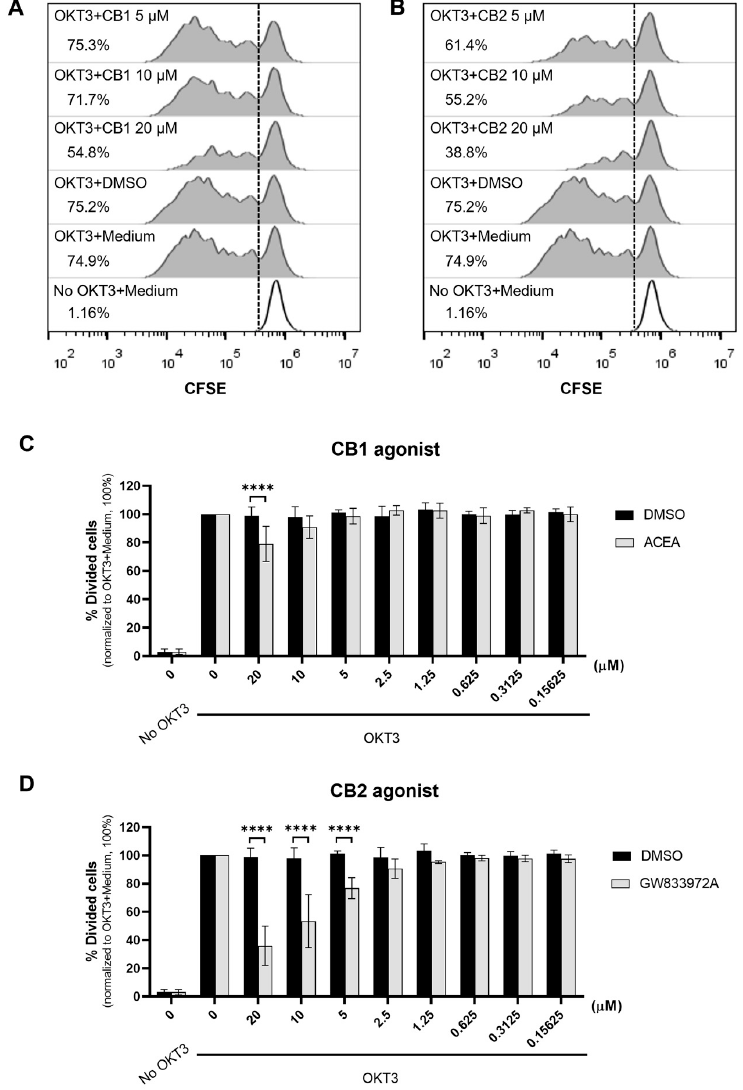
Figure 1. CB1 and CB2 agonists inhibit T cell proliferation. CFSE labeled PBMCs were activated with anti-CD3 mAb (OKT3) or kept unstimulated (No OKT3) in the presence of various concentrations of CB1 (ACEA) or CB2 (GW833972A) agonists or DMSO control (DMSO) for 5 days. The representative flow cytometric data of the CB1 agonist ( A ) and CB2 agonist ( B ) treatment and the relevant DMSO concentration for CB1 or CB2 agonists at 20 µ M are expressed in histograms showing the percentage of divided cells in each condition, which was determined using a CFSE proliferation assay. The percentage of divided cells in the presence of the indicated concentrations of CB1 agonist ( C ) and CB2 agonists ( D ) compared with that in the DMSO control is shown in bar graphs as mean ± SD (n = 8 for 0, 20, 10, and 5 µ M and n = 4 for other concentrations). Each individual datum was normalized relative to its medium control (OKT3 + Medium) as 100%. We used two-way ANOVA followed by Sidak’s multiple comparisons test for comparison; **** p <